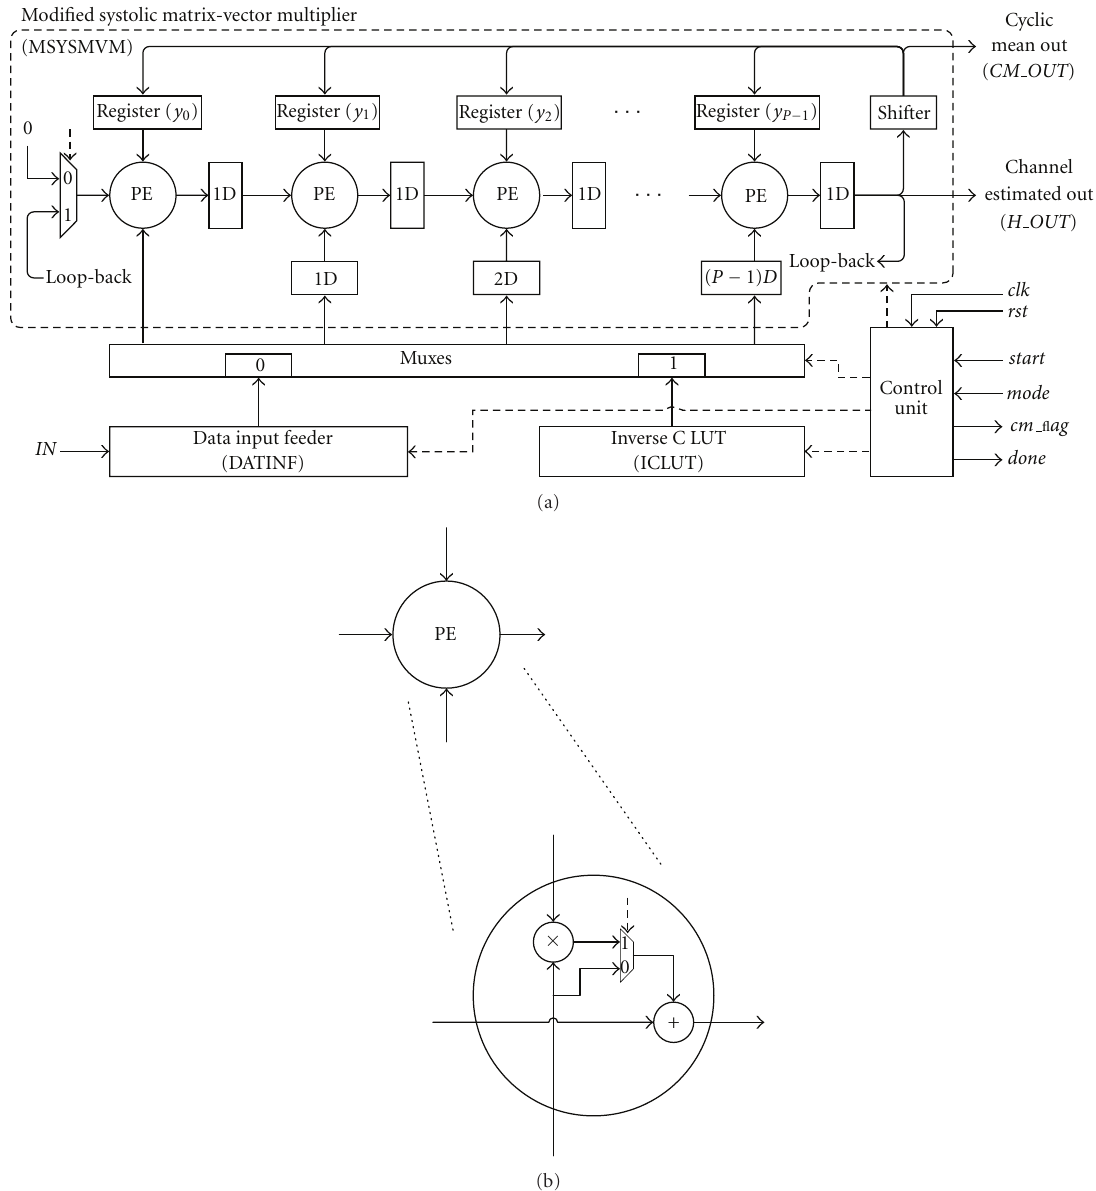
Figure 8: Systolic channel estimator for DDST receiver. (a) Simplified architecture; (b) the PE